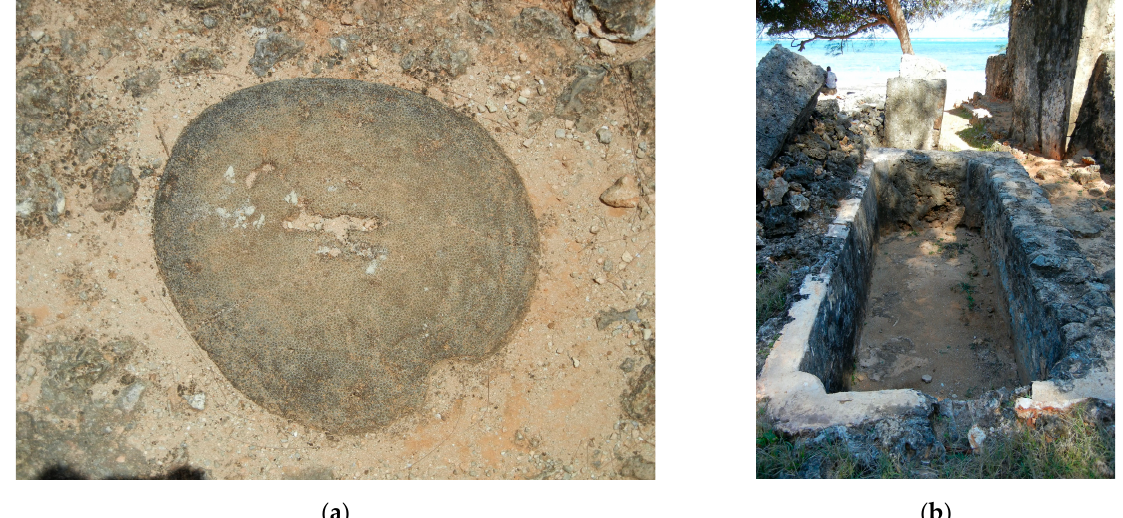
Figure 6. Footscrapers and ablution pools were located by the mosques and used for cleansing practices. They were of coral rag–the same material used for construction on the Swahili coast. ( a ) Footscraper from the Great Mosque by the Sea at Jumba la Mtwana, situated close to the ablution pool; ( b ) an ablution pool by the largest mosque on site, known as Great Mosque by the Sea, which was fed by a short conduit.